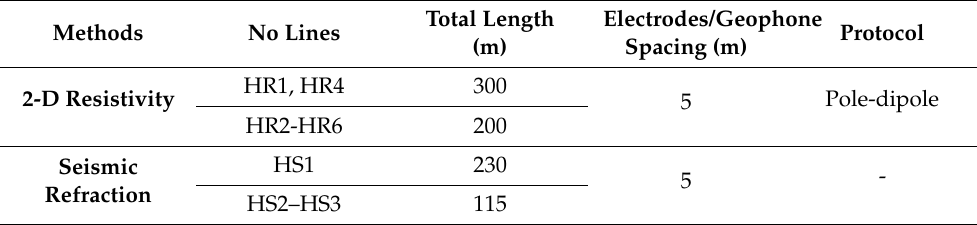
Table 1. Survey lines of Ulu Yam.